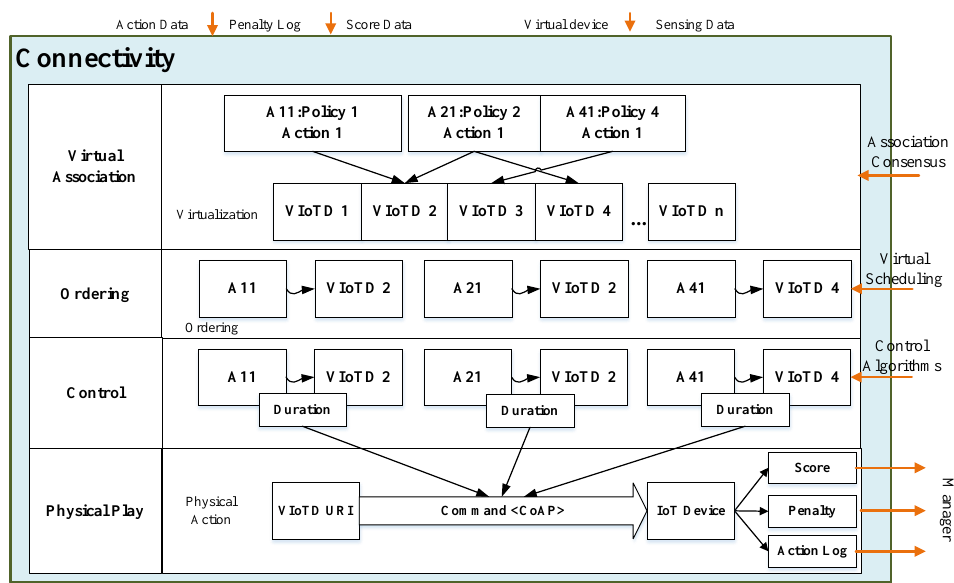
Figure 4. Flowchart of the IoT connectivity